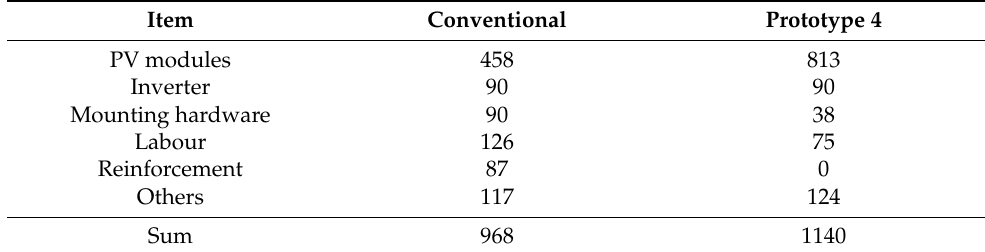
Table 9. Net prices in € per kWp of PV system.